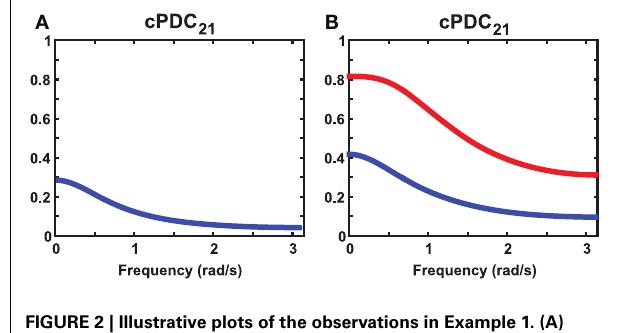
FIGURE 2 | Illustrative plots of the observations in Example 1. (A) cPDC 21 results for e = f = g = h = 0 in Example 1 revealing just one non-zero component under the ad = bc condition. (B) cPDC 21 when b = c = 0 and non-zero a and c in Example 1 leading to two non-zero components for any non-zero values of the e , f , g , h coefficients (the graph shown was produced using a = 0 . 5, b = 0, c = 0, d = 1, e = 0 . 3, f = − 0 . 1, g = 0 . 3, h = 0 . 4).